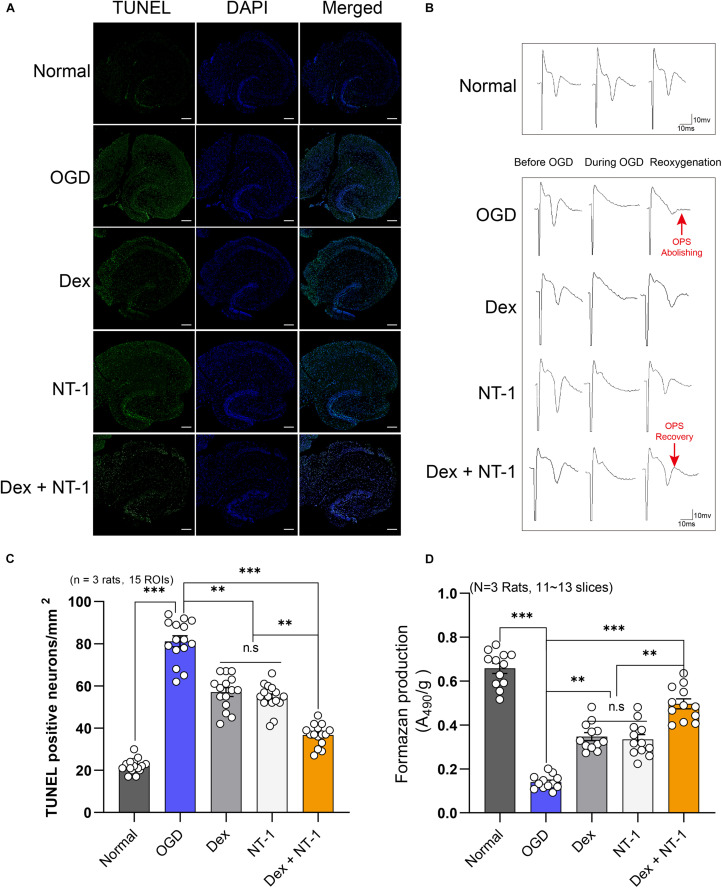
Combination of dexmedetomidine and Netrin-1 reduced the neuronal injury after OGD model. (A) Representative images of TUNEL-positive cells (green) in the hippocampal CA1 region. The nuclei were stained with DAPI. Scale bar = 200 μm. (B) OPS recordings of the CA1 region of hippocampal slices after reoxygenation treated with drugs. (C) Quantitative analysis of TUNEL-positive neurons. (D) Formazan production (A490/g) after OGD insult treated with drugs. Data are shown as the mean ± SD. ∗P < 0.05, ∗∗P < 0.01 and ∗∗∗P < 0.001 using one-way ANOVA followed by Tukey’s post hoc tests.